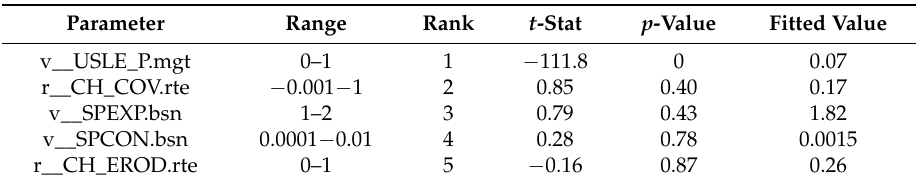
Table 5. Result of monthly sensitivity analysis and final calibrated sediment parameters for the ParaSol–SWAT–CUP package.